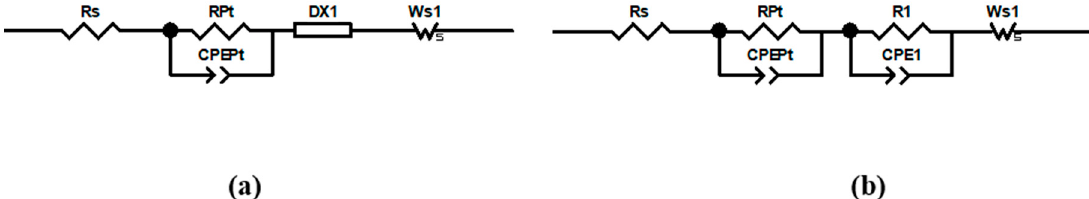
Figure 4. The two di ff erent equivalent circuit models used in this study: ( a ) the equivalent circuit model 1 used for fitting N719-sensitized dye-sensitized solar cells (DSCs); ( b ) the equivalent circuit model 2 used for fitting the DSCs with N719 or SQ2 as a